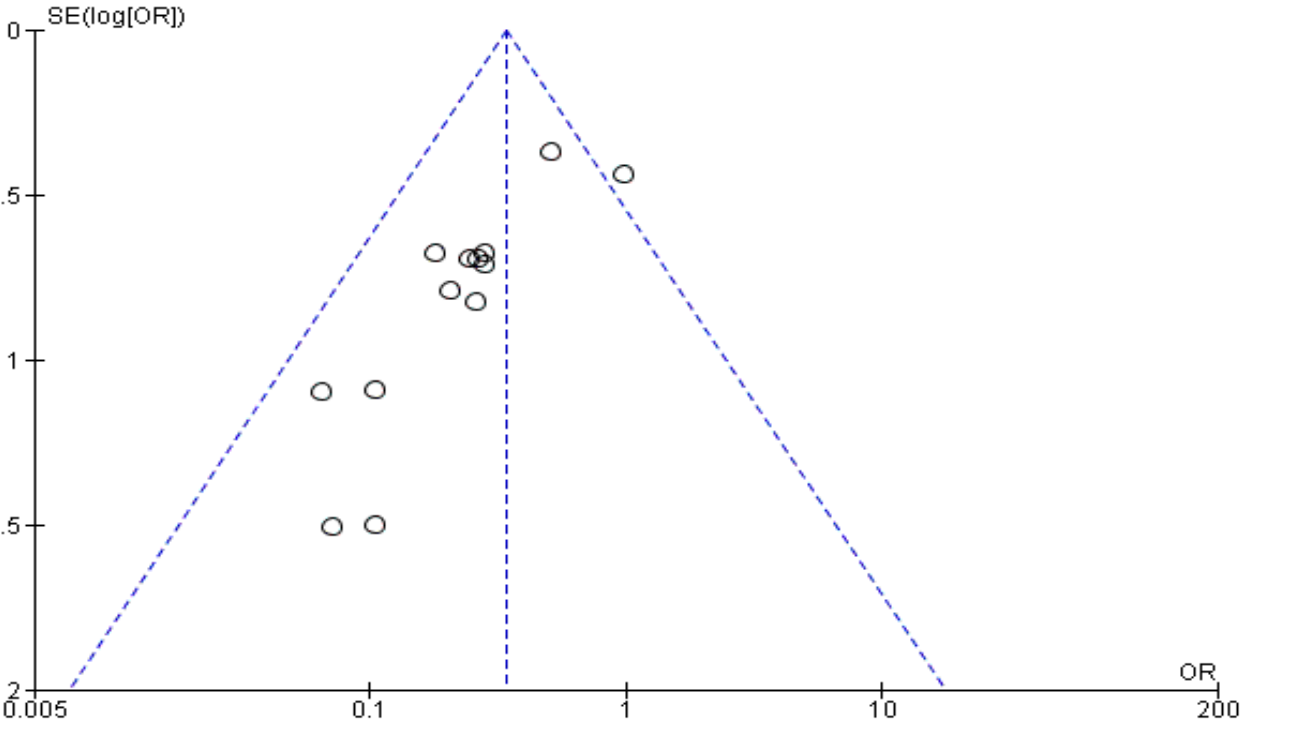
Figure 7. Funnel plot of the studies included in the analysis of the number of accidentally removed parathyroid glands.